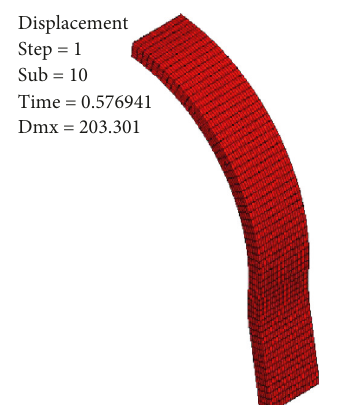
Figure 7: Deformation of the